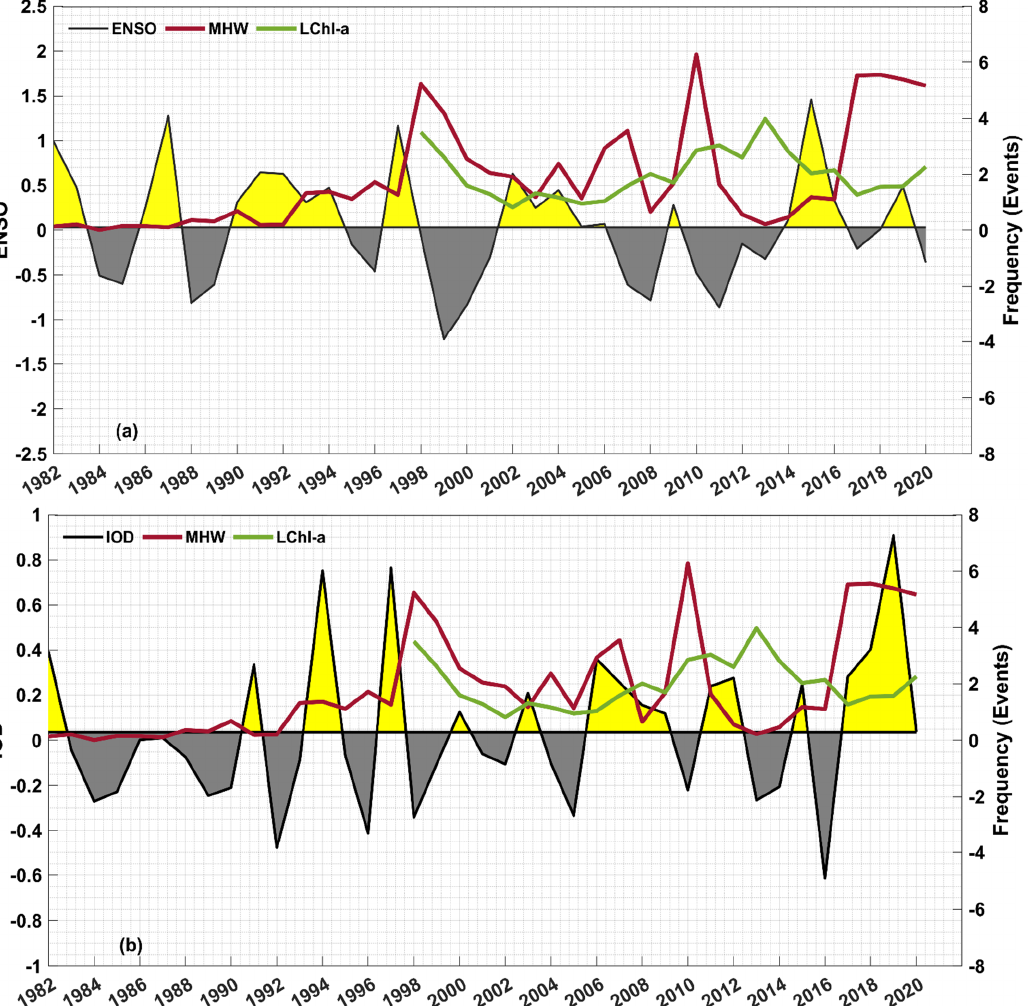
Figure 9. The annual time series of the normalized Niño 3.4 (ENSO) (shading, in ( a )) and the Indian Ocean Dipole (IOD) (shading, in ( b )), with the annual MHW frequency of (solid red line) from 1982 to 2020, and annual LChl-a frequency (solid green line) from 1998 to 2020 for the entire study area. The yellow and grey shading refer to the positive and negative phases of the climate indices, respec- tively.